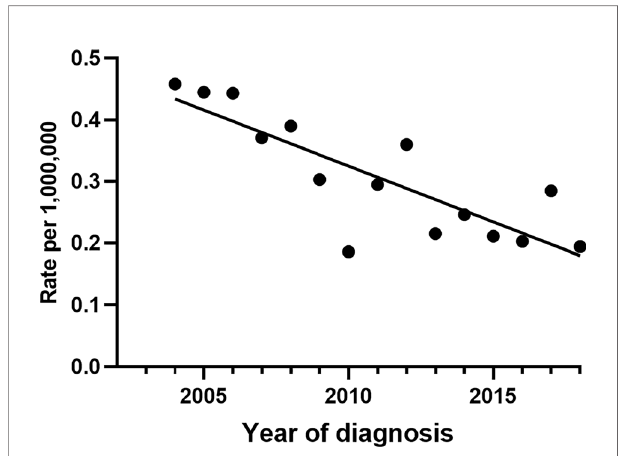
FIGURE 1 | Incidence of CDCK in the period 2004 –